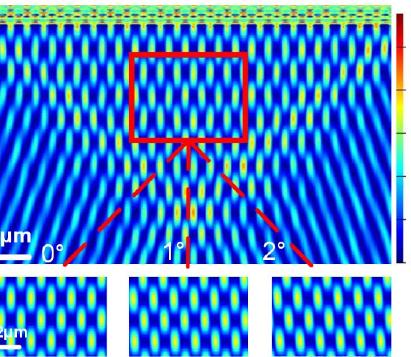
Figure 2. Simulated normalized intensity field of Talbot images behind G1. Simulations of Talbot images with θ of 0°, 1° and 2°, respectively.